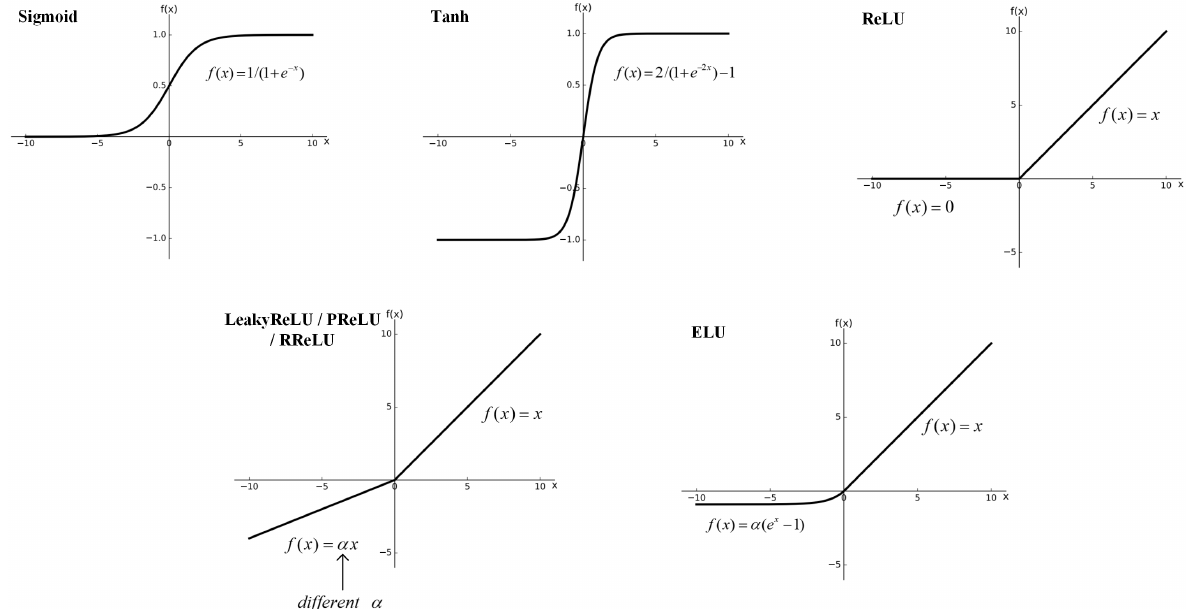
Figure 6. Pooling operation, it does not involve zero